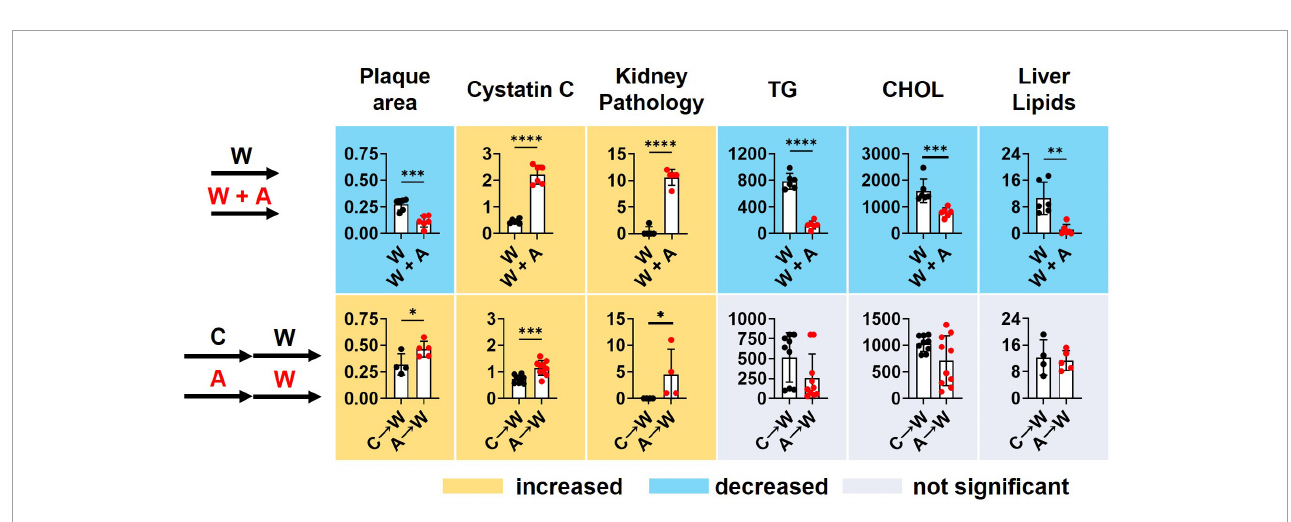
FIGURE9 Summary of key findings. T -test; ∗ p < 0.05; ∗∗ p < 0.01; ∗∗∗ p < 0.001; ∗∗∗∗ p < 0.0001.